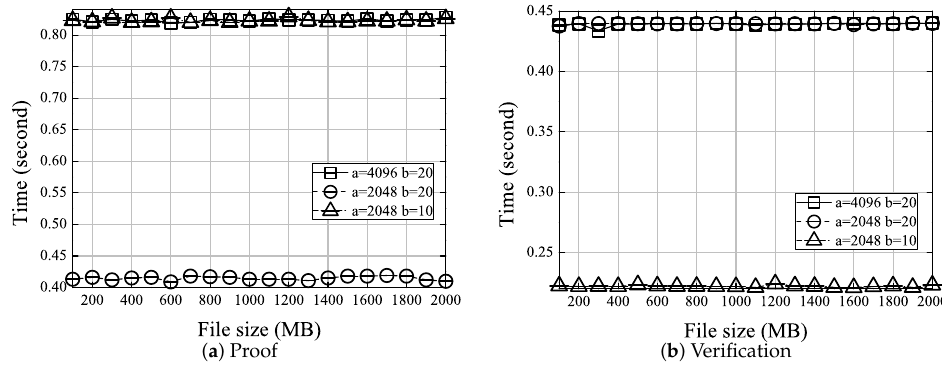
Figure 3. Computational cost for various components in Case 2 of Upload